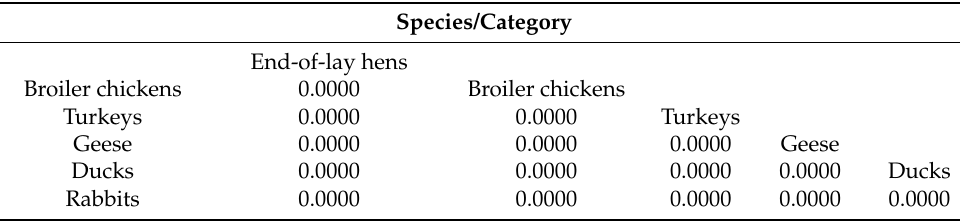
Table 2. The pairwise comparisons ( p -value) of frequency of traumatic injuries to the limbs in monitored animal species and categories.